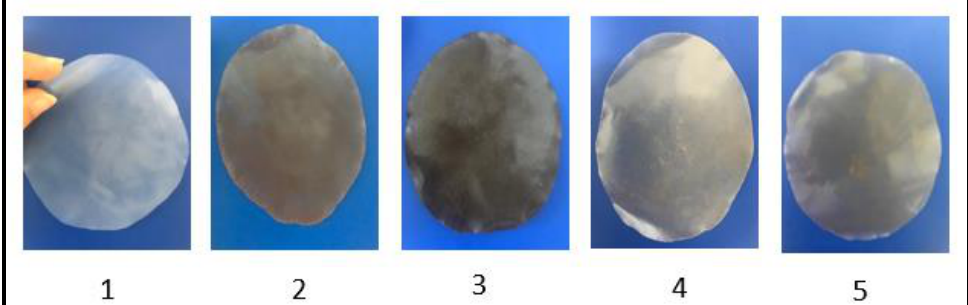
Figure 2. Preparation of composite. 1: BioPE 100%; 2: BioPE-30% shell; 3: BioPE-30% pulp; 4: BioPE- 30% unroasted argan cake; 5: BioPE-30% roasted argan cake. 30% unroasted argan cake; 5: BioPE-30% roasted argan